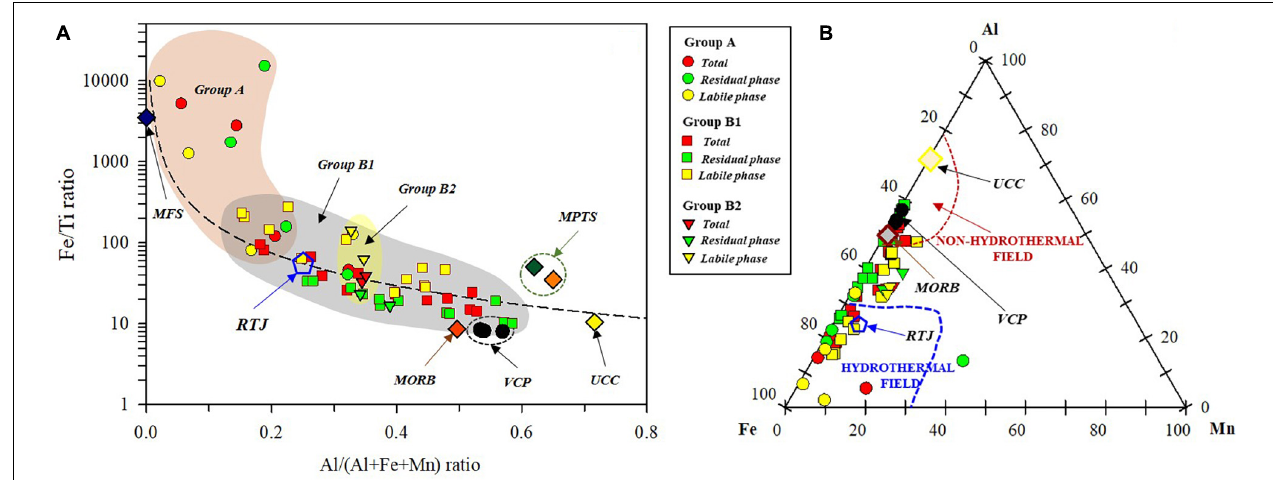
FIGURE 3 | (A) Al/(Al + Fe + Mn) vs. Fe/Ti discrimination diagram of mixing hydrothermal metalliferous sediments with deep-sea sediments (after Marchig et al., 1982; Boström, 1983). Curved line represents ideal mixing between Al-free hydrothermal sediment (MFS) and modern pelagic or terrigenous sediments (MPTS). (B) Ternary Fe–Mn–Al diagram indicating the hydrothermal affinity of the OVF sediments (after Adachi et al., 1986). RTJ, Average value of core top sediments from the Rodrigues Triple Junction (RTJ), Central Indian Ocean (Kuhn et al., 2000); UCC, upper continental crust (Taylor and McLennan, 1985); MORB, mid-ocean ridge basalt (Gale et al., 2013); VCP, volcaniclastic particles (this